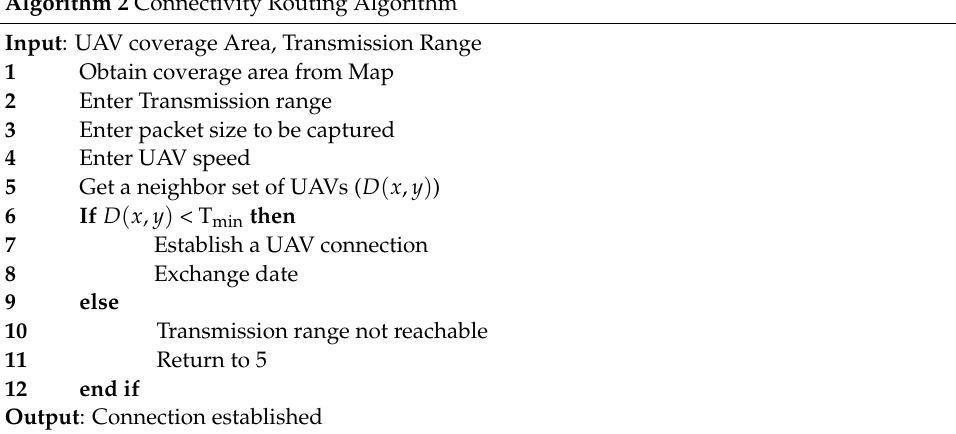
Algorithm 2 Connectivity Routing